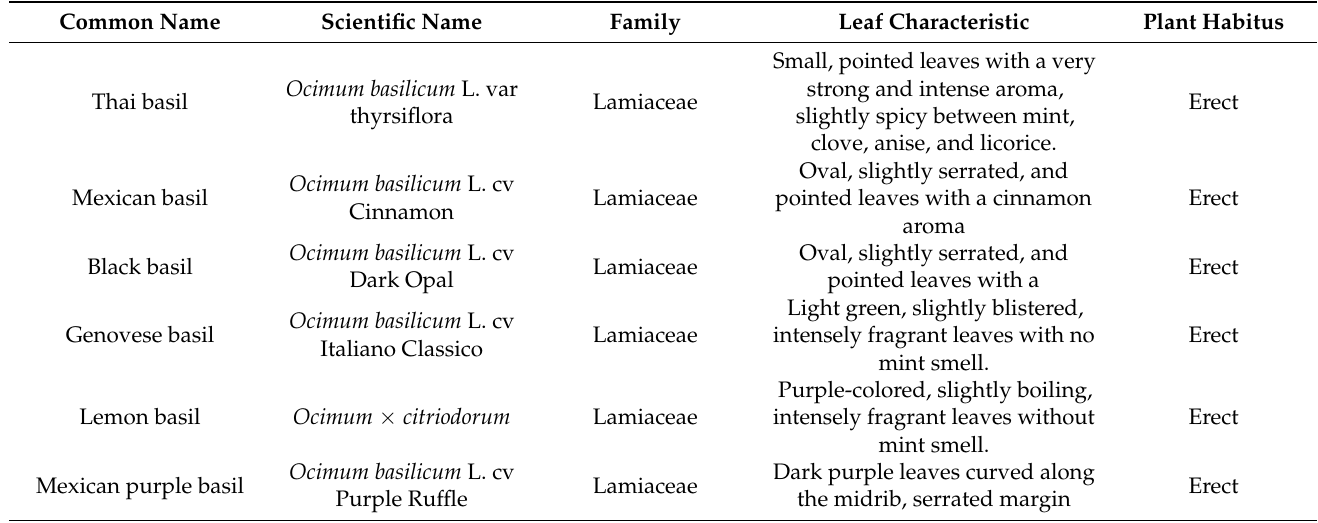
Table 5. Comparison of morphological characteristics of Thai, Mexican, Black, Genovese, Lemon, and Mexican Purple